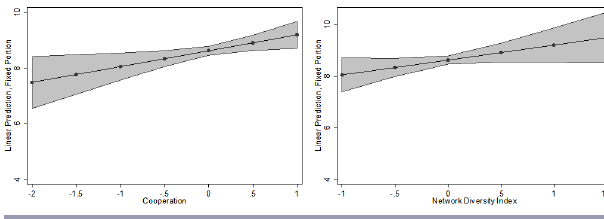
Fig. 4 . Effect of board member cooperation and network diversity on predicted perceptions of success. Both cooperation and network diversity are mean centered, with 0 representing the average level of cooperation and functional network diversity among land trusts in the sample. The shaded area is the 95% confidence interval of the marginal effects. Interval values are derived from model 4 (Table 5) with the mean values for all other